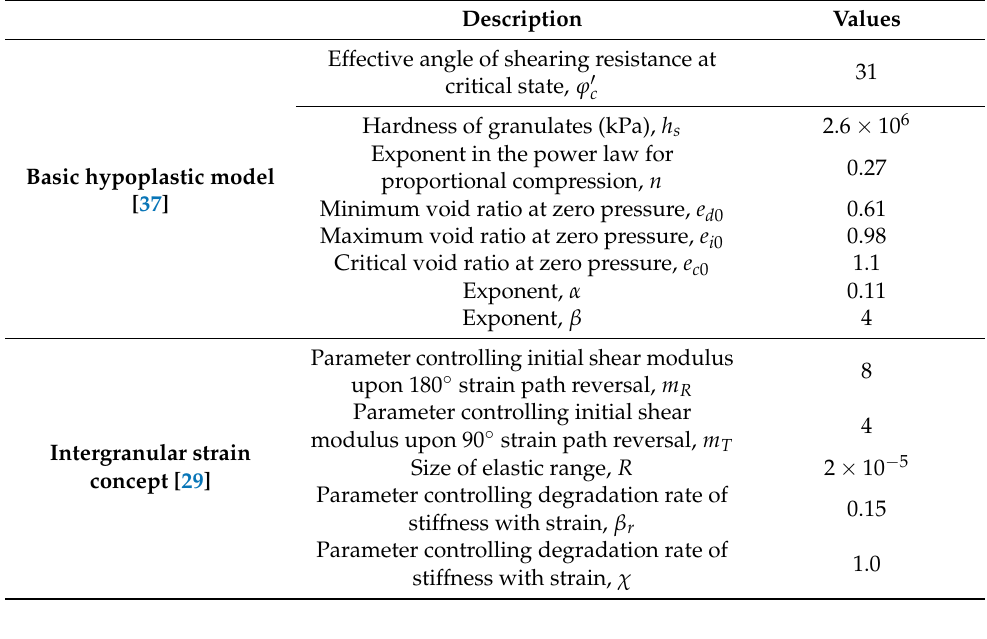
Table 3. Calibrated parameters of hypoplastic model for Toyoura sand [42].